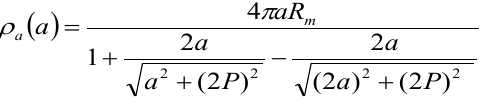
Fig. 2. Lateral Profiling Method.